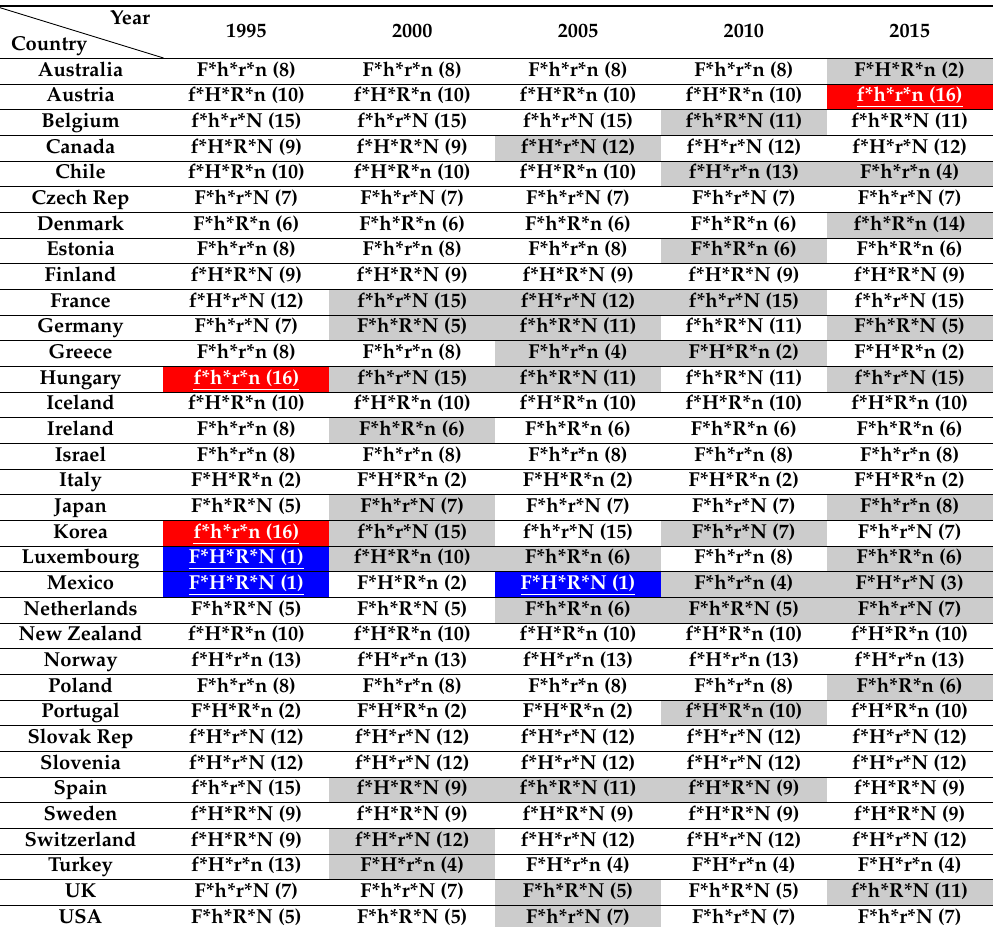
Table 6. Changes and continuity of ideal types by OECD countries from Y1995 to